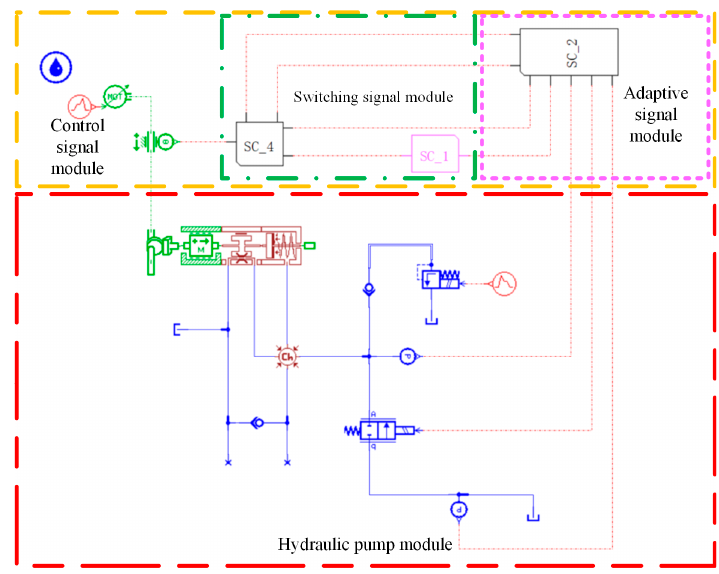
Figure 4. Simulation model of the digital pump. Table 1. Main performance parameters.